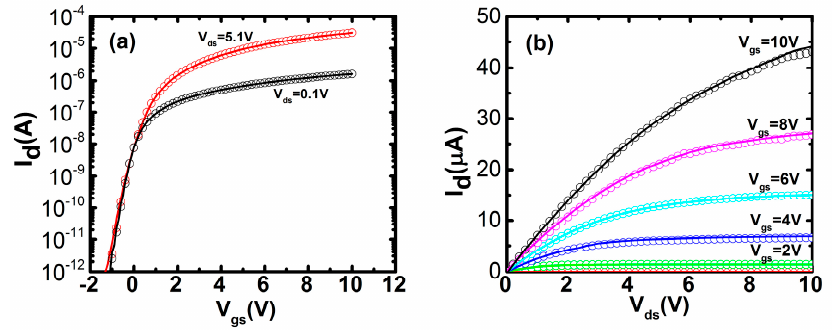
Figure 8. Experimental data (symbols) and simulated results (solid lines) of IZO TFTs with W / L = 20 μ m/10 μ m. ( a ) Transfer characteristics; ( b ) output characteristics.